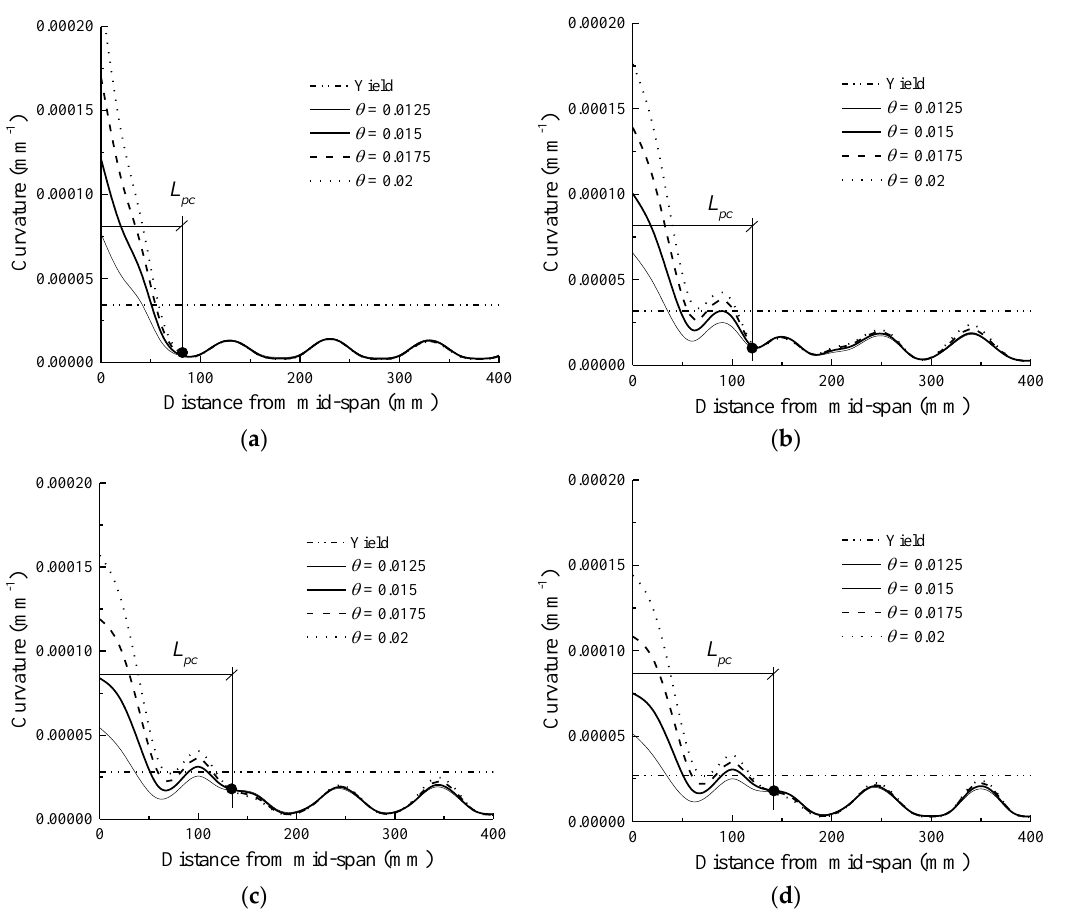
Figure 8. Curvature distribution along beam length: ( a ) ρ r = 0; ( b ) ρ r = 0.33; ( c ) ρ r = 1; ( d ) ρ r = 3.